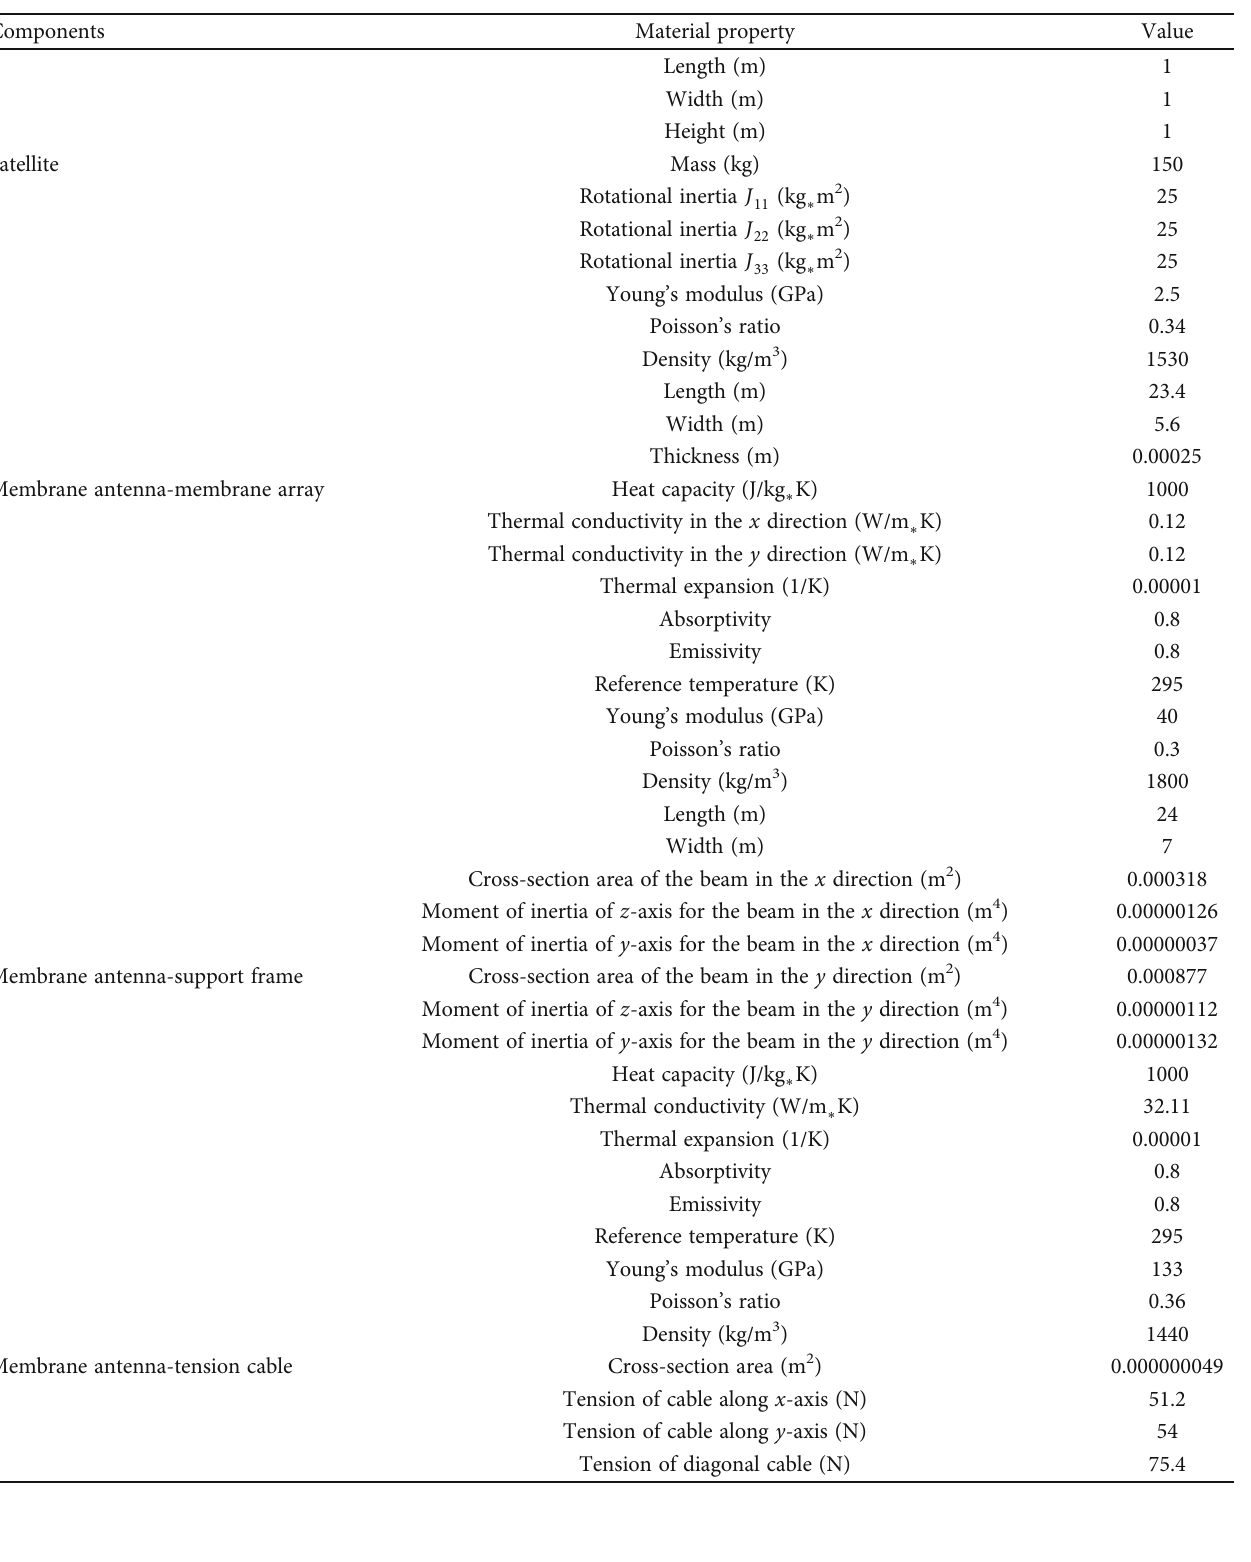
Table 1: Mechanical and thermal parameters of the membrane-antenna-satellite